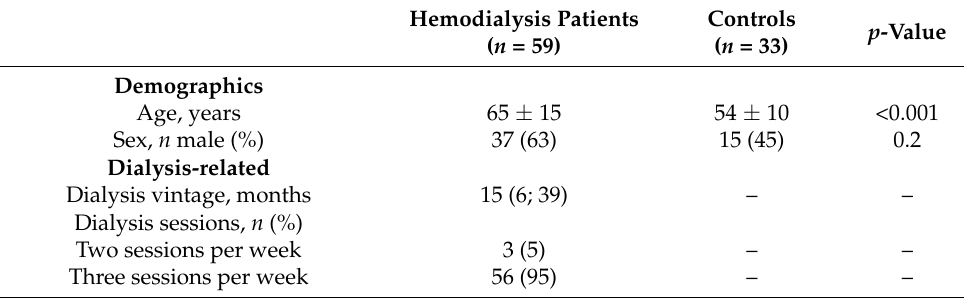
Table 1. Baseline characteristics of the hemodialysis patients and